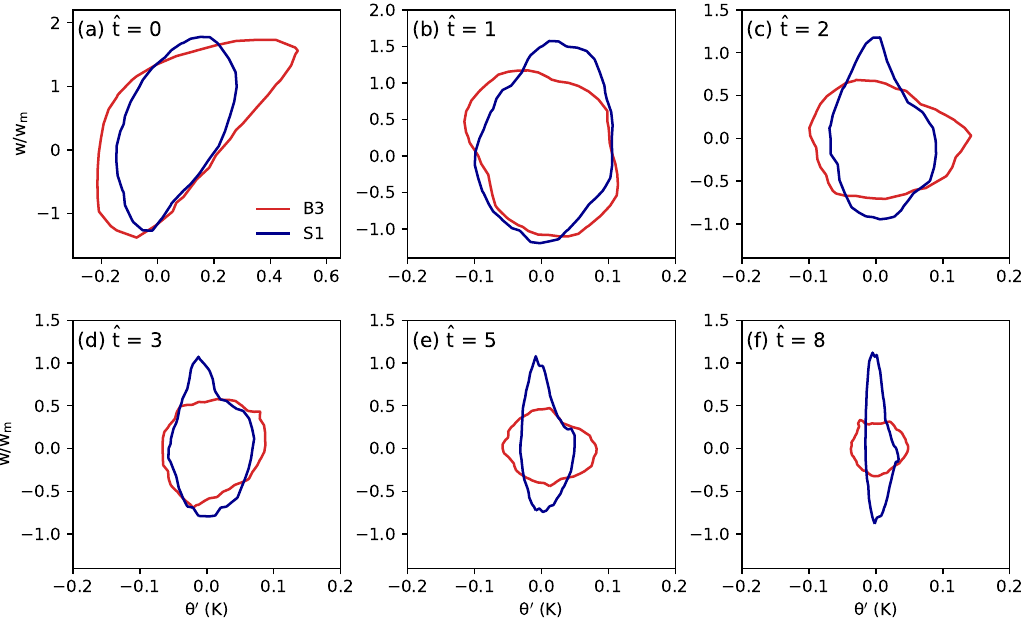
Figure 8. Joint probability density functions (PDFs) of potential temperature perturbation and normalized vertical velocity in the B3 and S1 cases at ˆ t = ( a ) 0, ( b ) 1, ( c ) 2, ( d ) 3, ( e ) 5, and ( f ) 8. Contours of the value 0.1 are